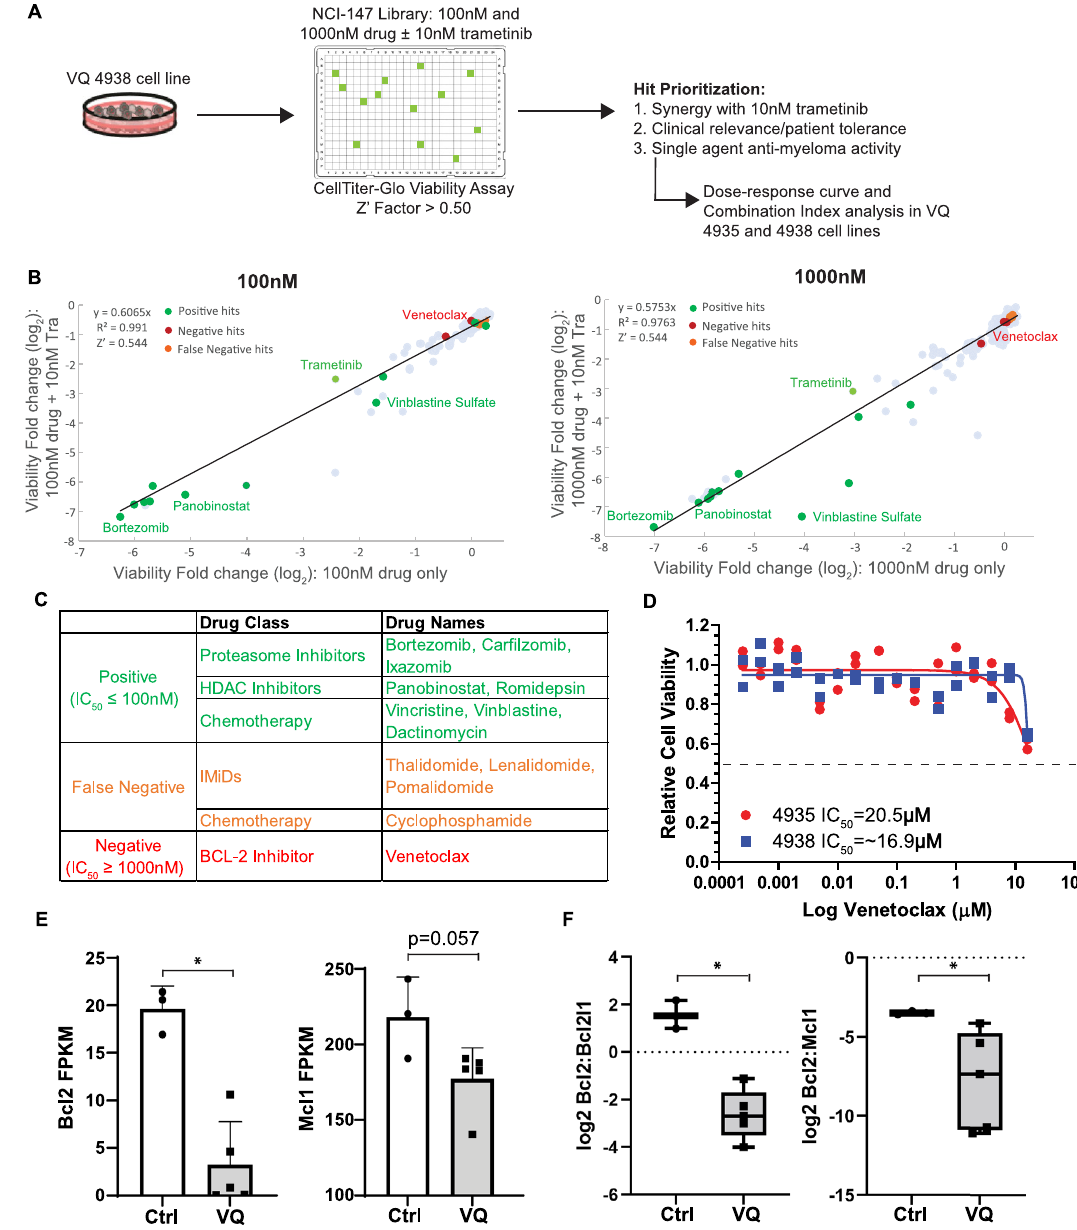
Figure 1. Re-purposing screen identifies de novo resistance of VQ MM cells to venetoclax. ( A ) Scheme of drug screening procedure against VQ myeloma cells. ( B ) AOD IX screening results for compounds at 100 nM and 1000 nM concentration alone or in the presence of 10 nM Trametinib. Results are plotted as Log2 fold change in viability relative to DMSO-treated control wells as measured by CellTiter-Glo Luminescent Assay after 48 h of treatment. Notable compounds are highlighted-see accompanying table in ( C ). ( C ) Table detailing selected positive, false negative, and true negative hits from the AOD IX library as highlighted in ( B ). ( D ) VQ 4935 and 4938 cells were treated with the indicated concentration of venetoclax for 48 h. Relative viability to DMSO treated control was then measured using the CellTiter-Glo assay. IC 50 values were calculated by logistic regression using the GraphPad Prism software. ( E ) Transcript levels of anti-apoptotic genes Bcl2 and Mcl1 in CD138 + B220 - cells from control bone marrow (BM) or VQ recipient BM. FPKM, Fragments Per Kilobase of transcript per Million mapped reads. ( F ) Ratios of Bcl2:Bcl2l1 and Bcl2:Mcl1 gene expression levels. Results are presented as mean + SD. * p <